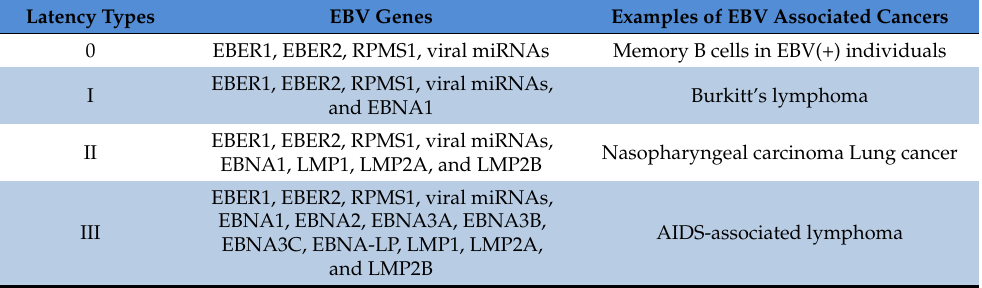
Table 1. EBV gene expression in different types of